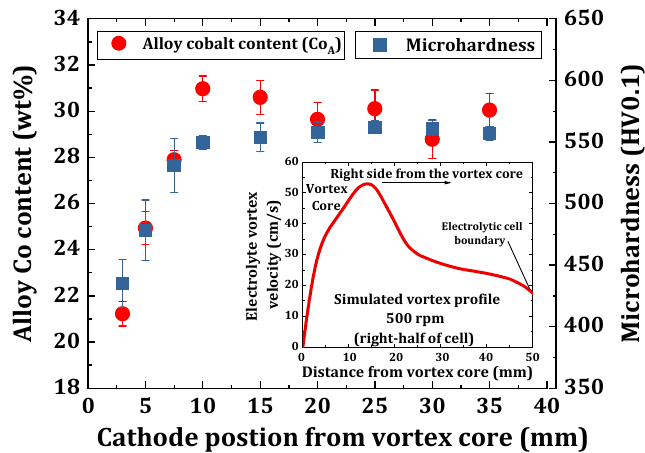
Figure 3. Influence of the varying electrolyte flow velocity in vortex on the alloy Co content and the resultant microhardness of eNiCo alloy samples, electrodeposited at 500 rpm, 50 mA/cm 2 , 45 °C, pH 4 for 1 h. The inset shows the simulated vortex profile (right-half) at 500 rpm for NiCo electrolyte.